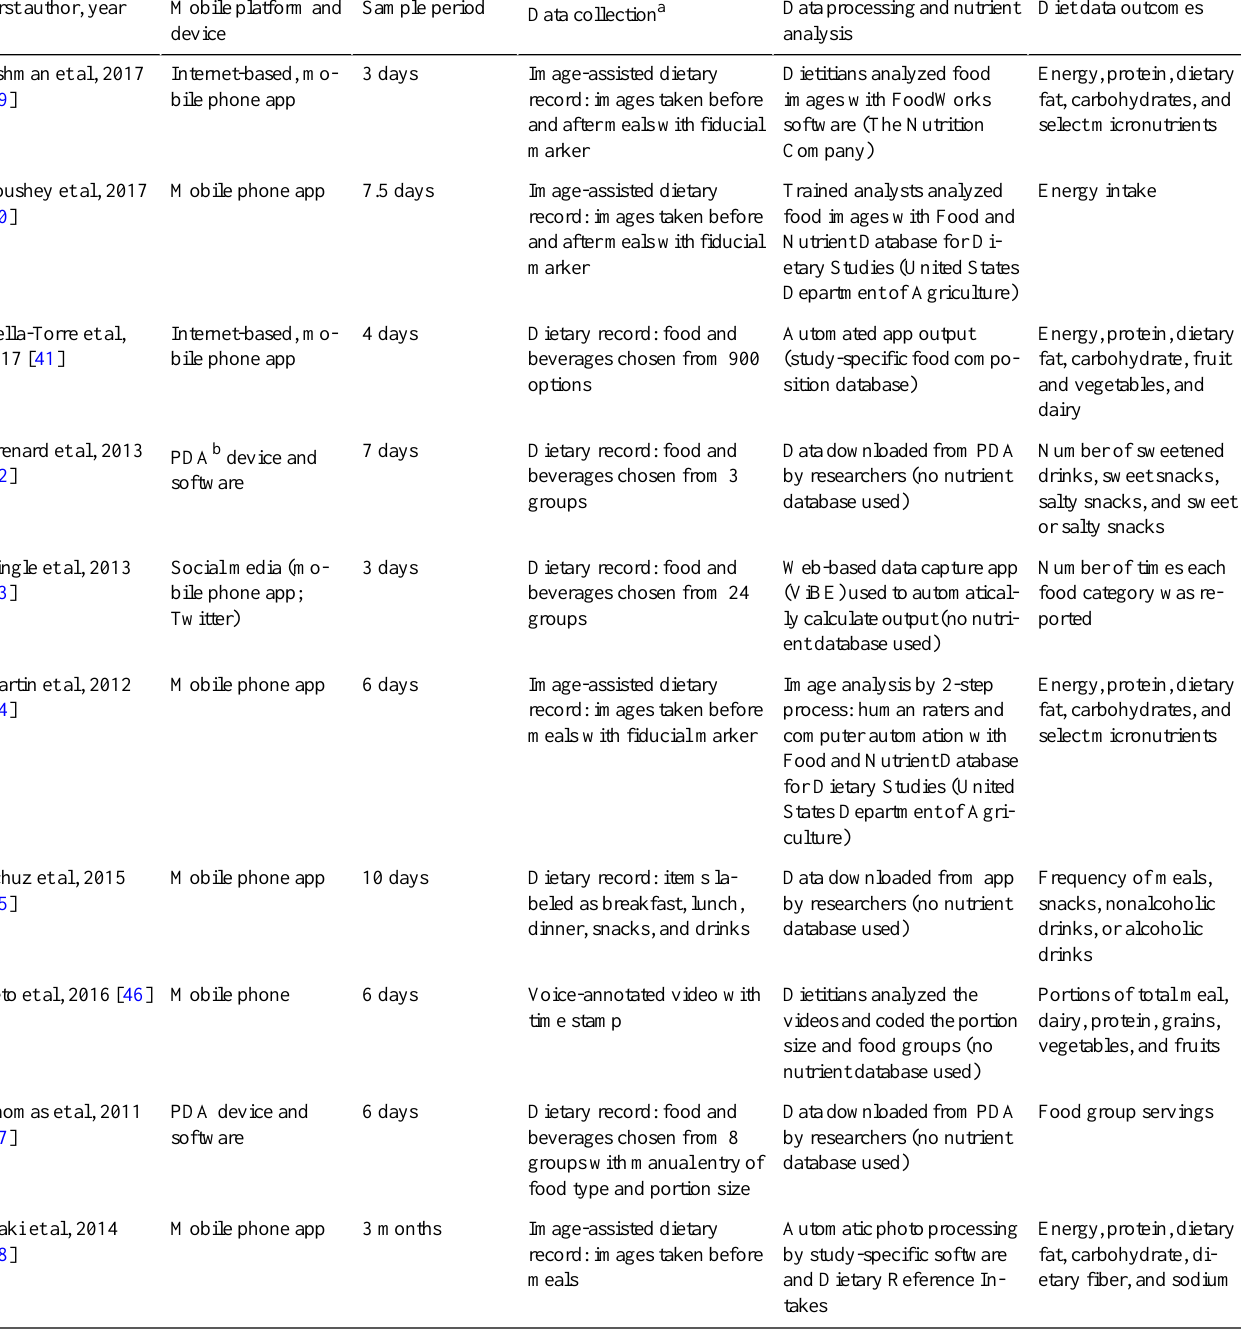
Table 1. Event-contingent, mobile ecological momentary dietary